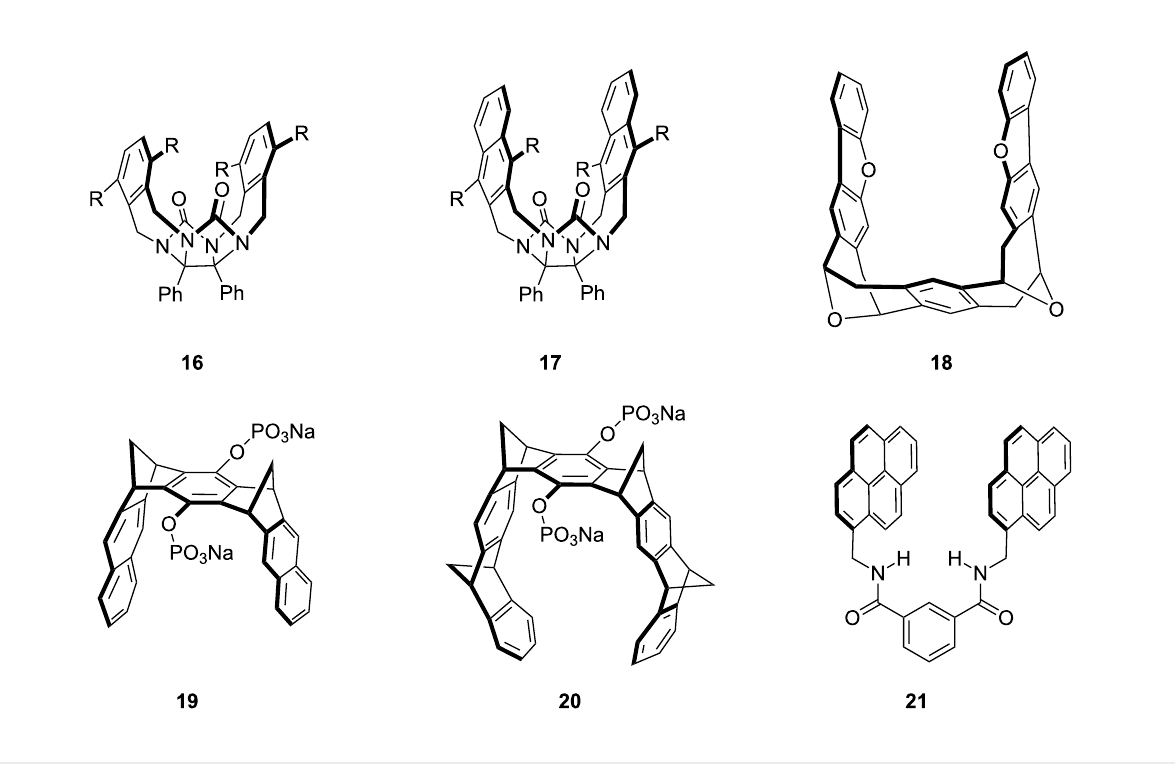
Figure 6: Glycouril-based molecular clip 16 and 17 developed by Nolte, an example of Harmata’s chiral Kagan-ether tweezer 18 , two of Klärner’s water-soluble tweezers ( 19 and 20 ), and pyrene tweezer 21 studied by Colquhoun.